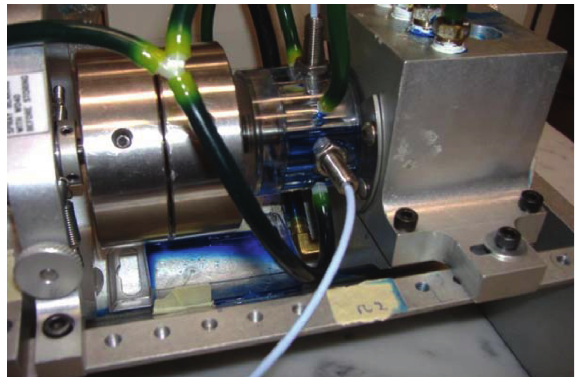
Figure 1: Instrumented hydrodynamic bearing with proximity